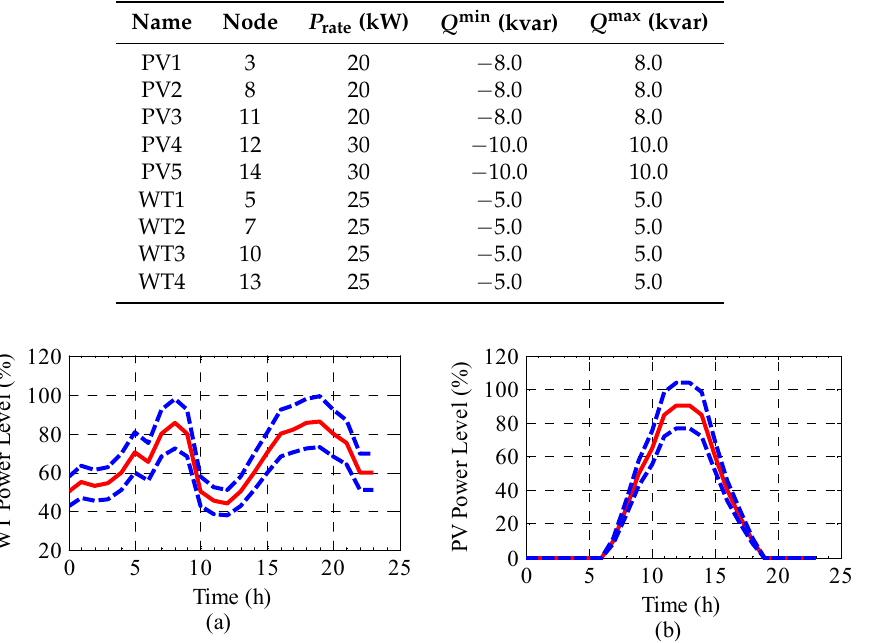
Table 2. Parameters of PVs and WTs of the microgrid.